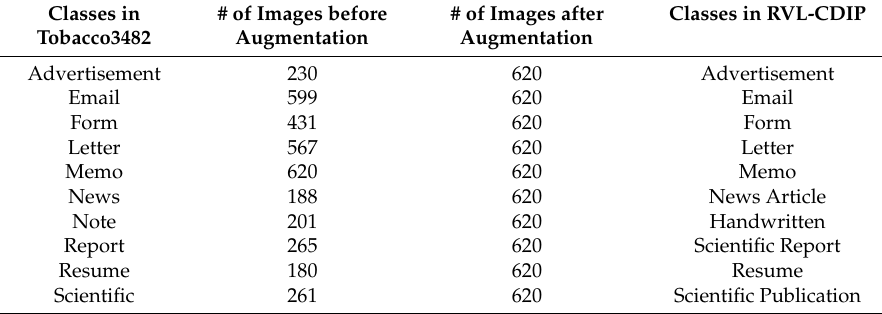
Table 2. Dataset before and after applying the data augmentation